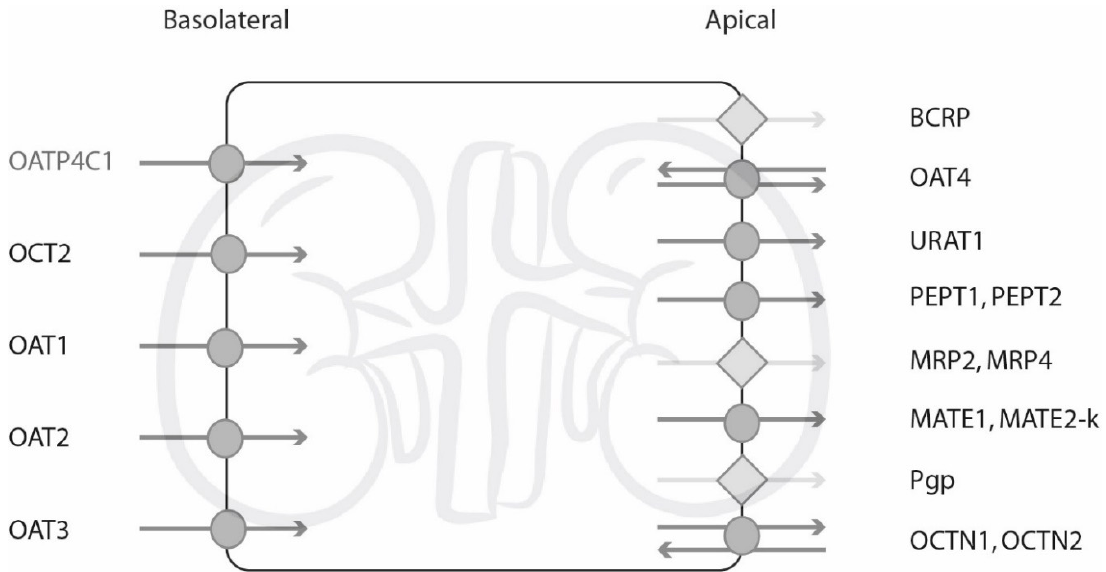
Figure 2. Human renal uptake transporters in the basolateral and apical membrane. In this study, transporters depicted as a circle in darker grey were investigated using a cellular assay, and diamond-shaped transporters in light grey with a vesicular assay. Figure adapted from Giacomini et al., Ivanyuk et al., and Yin et al. (references in text).